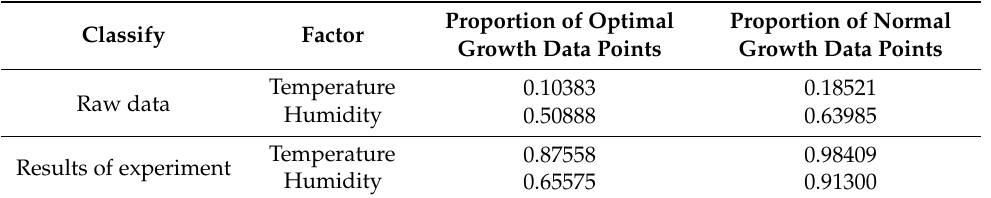
Table 7. The proportion of each interval in the experimental